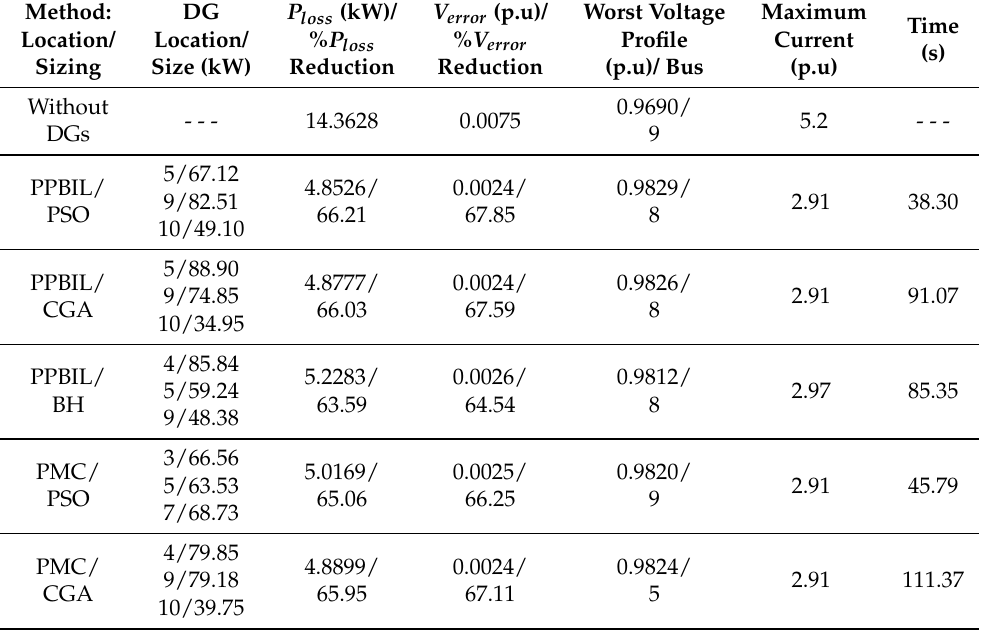
Table 5. Results of the 10 bus test